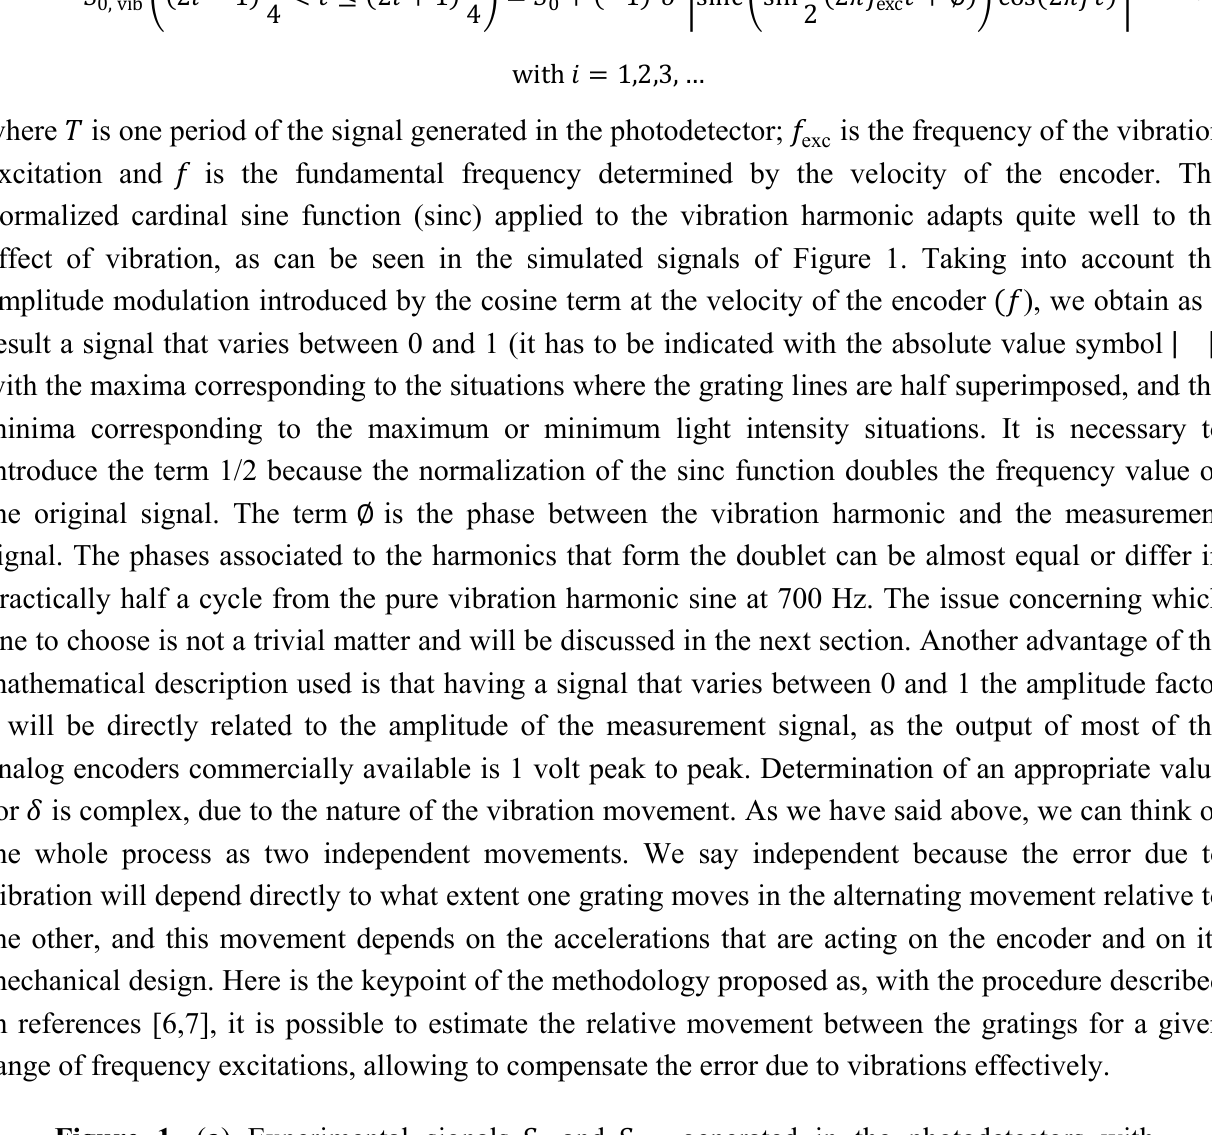
and (cid:1845) generated in the photodetectors with (cid:2868) (cid:2869)(cid:2876)(cid:2868) and simulation by means of Equation (5); ( b ) FFT of the (cid:3002) (cid:3002)